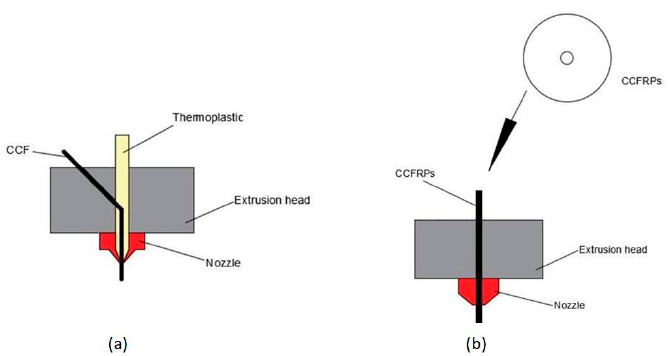
Figure 1. ( a ) The real-time 3D printing of CCF with thermoplastic and ( b ) printing CCFRPs based